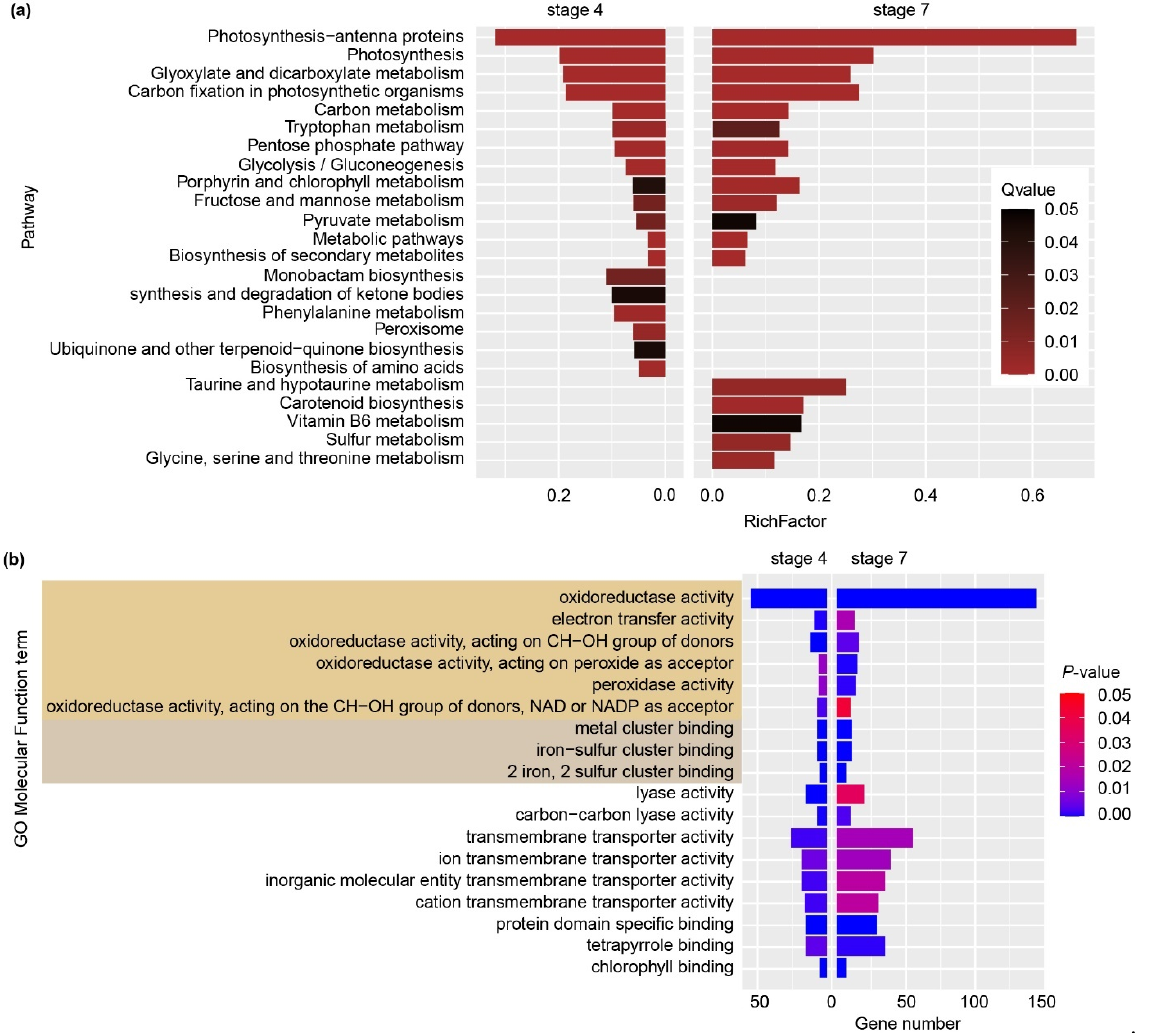
Figure 3. KEGG and Gene ontology (GO) enrichment analysis of transcripts significantly differently expressed in stage 4 and stage 7 petunia petal after exposure to excess Cu. ( a ) Enriched KEGG pathway in petunia petal upon excess Cu exposure by using p -value < 0.05 as a cut-off. ( b ) Enriched GO terms in molecular function ontology on level 3 to level 6 shared by stage 4 and stage 7 petal transcriptomes. Terms related to “oxidoreductase activity” and “metal cluster binding” are marked with colored backgrounds.